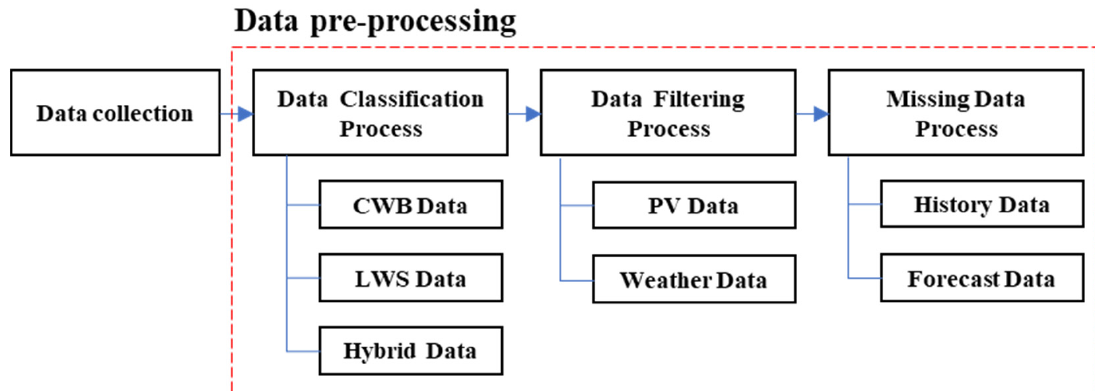
Figure 4. Data pre-processing structure.